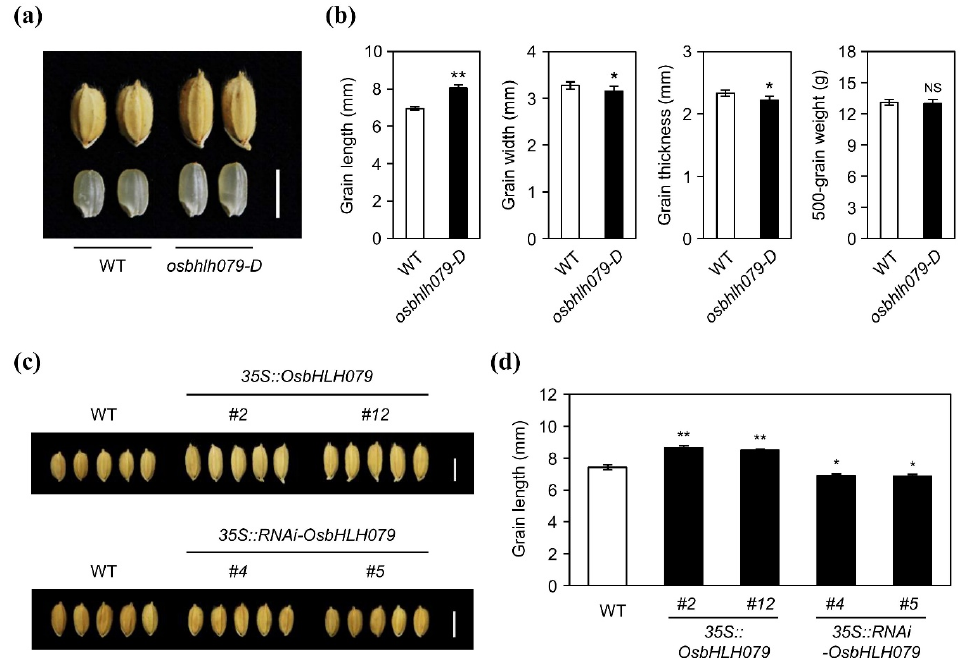
Figure 3. The grain phenotypes of WT, osbhlh079-D , 35S::OsbHLH079 , and 35S::RNAi-OsbHLH079 . ( a ) Unhulled and hulled grain phenotypes of the osbhlh079-D mutant compared to those of WT. Scale bar = 0.5 cm. ( b ) Comparison of grain length, grain width, grain thickness, and 500-grain weight between WT and the osbhlh079-D mutant. Means and standard deviations were